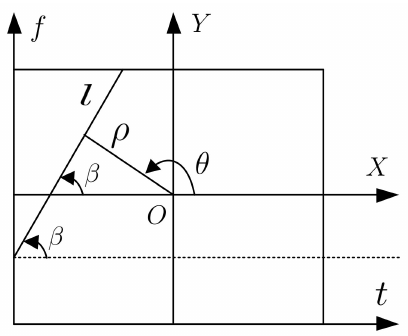
Figure 4. Scheme of Hough